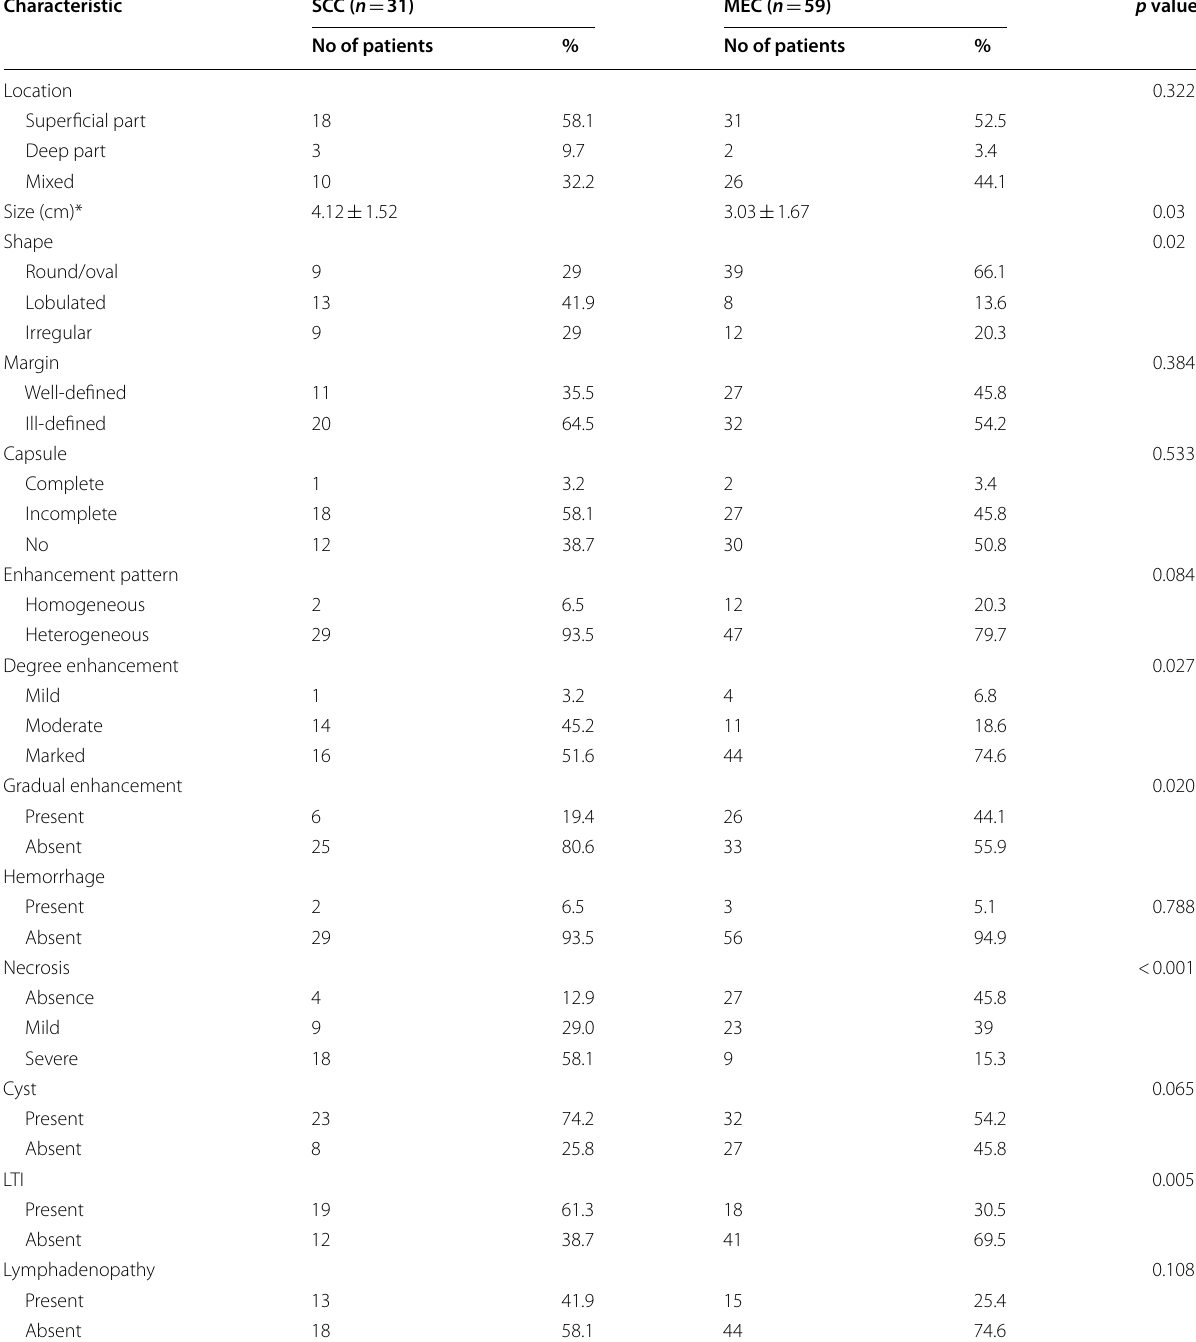
Table 1 CT and MRI characteristic and univariate analyses of primary parotid SCC and